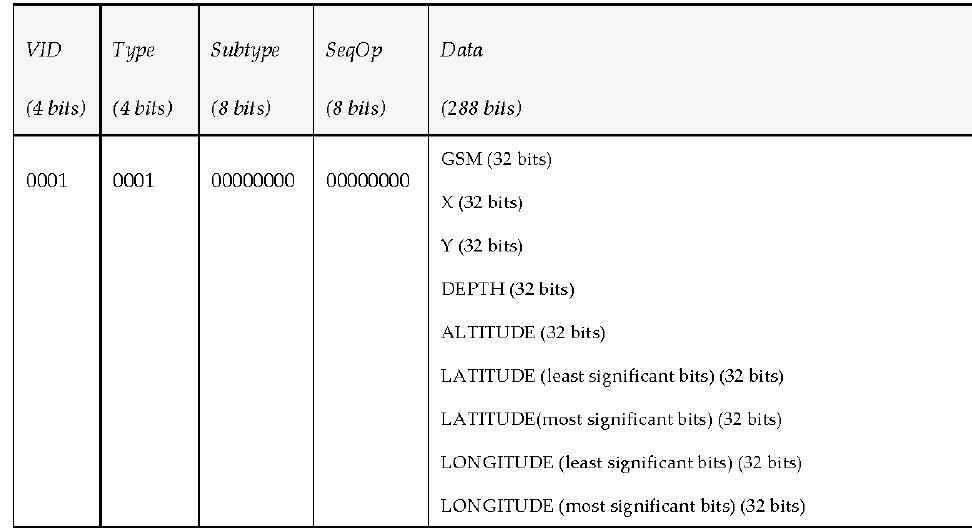
Figure 8. Time measurements for periodic environmental data subscriptions.